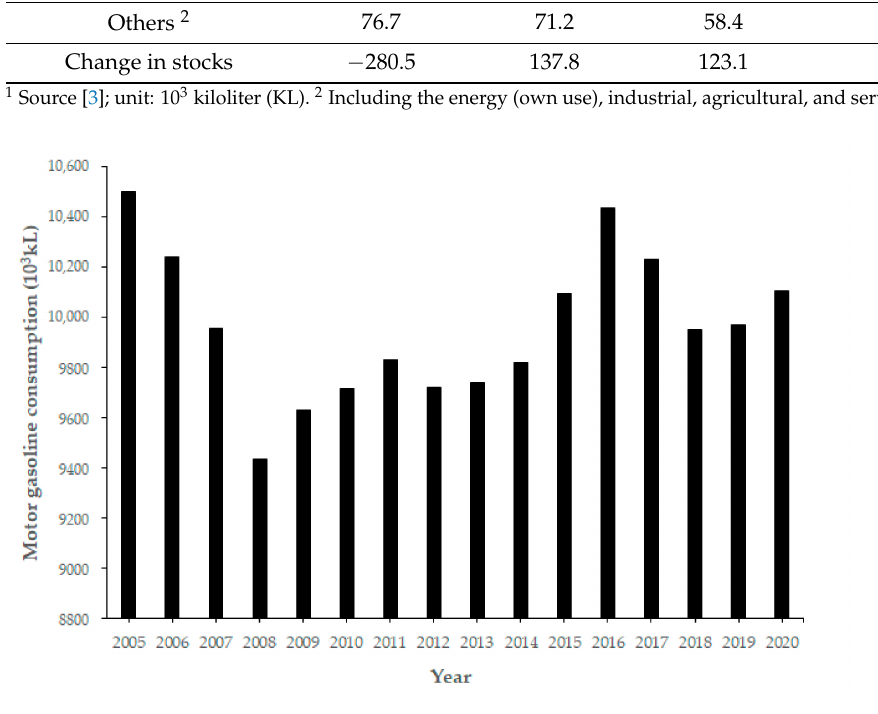
Figure 1. Variations of motor gasoline consumption during